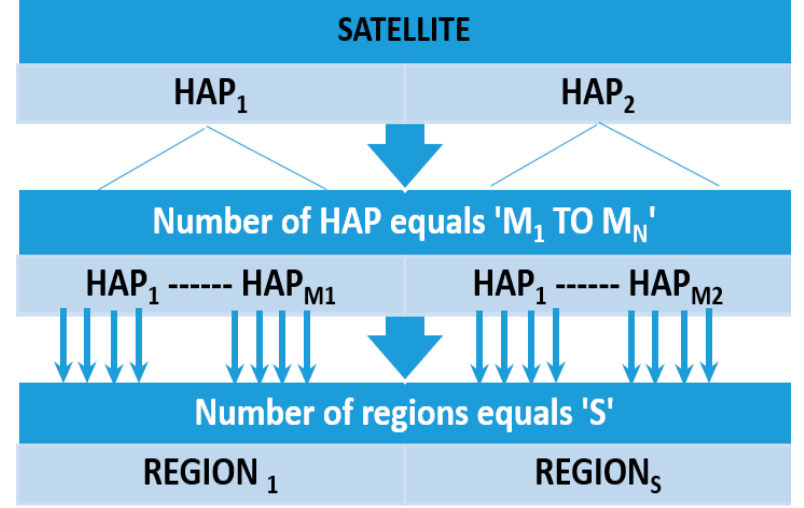
Figure 2. The coverage